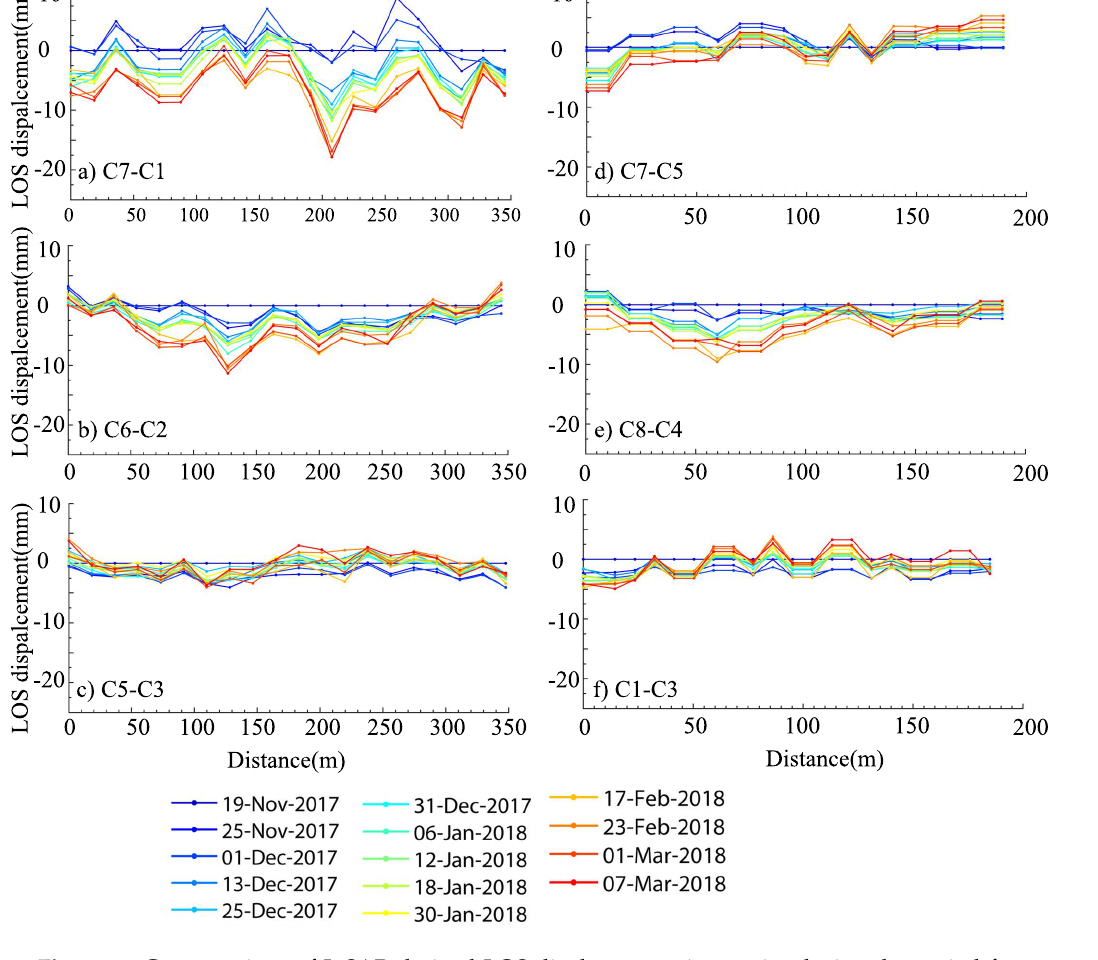
Figure 9. Cross-sections of InSAR-derived LOS displacement time series during the period from November 2017 to March 2018. ( a ) C1–C7, ( b ) C6–C2, ( c ) C5–C3, ( d ) C7–C5, ( e ) C8–C4, and ( f ) C1–C2. Note (i) negative values indicate that the surface moved away from the satellite radar; (ii) the location of each cross-section is shown in Figure